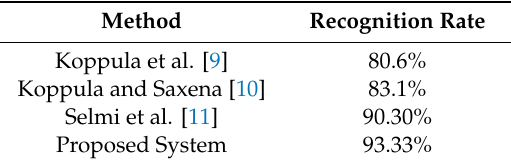
Table 7. Comparison of performance on the CAD-120